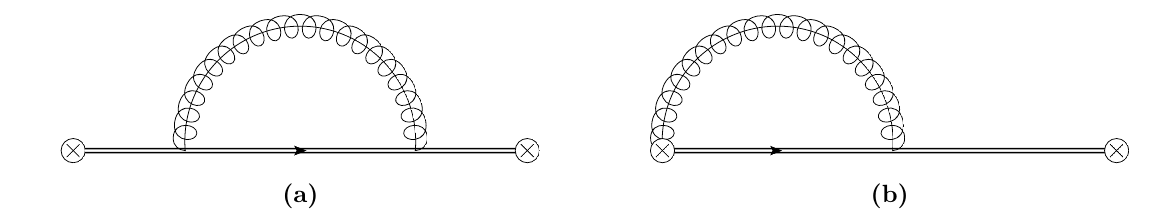
Figure 23. Diagrams relevant for computation of the bHQET jet function at